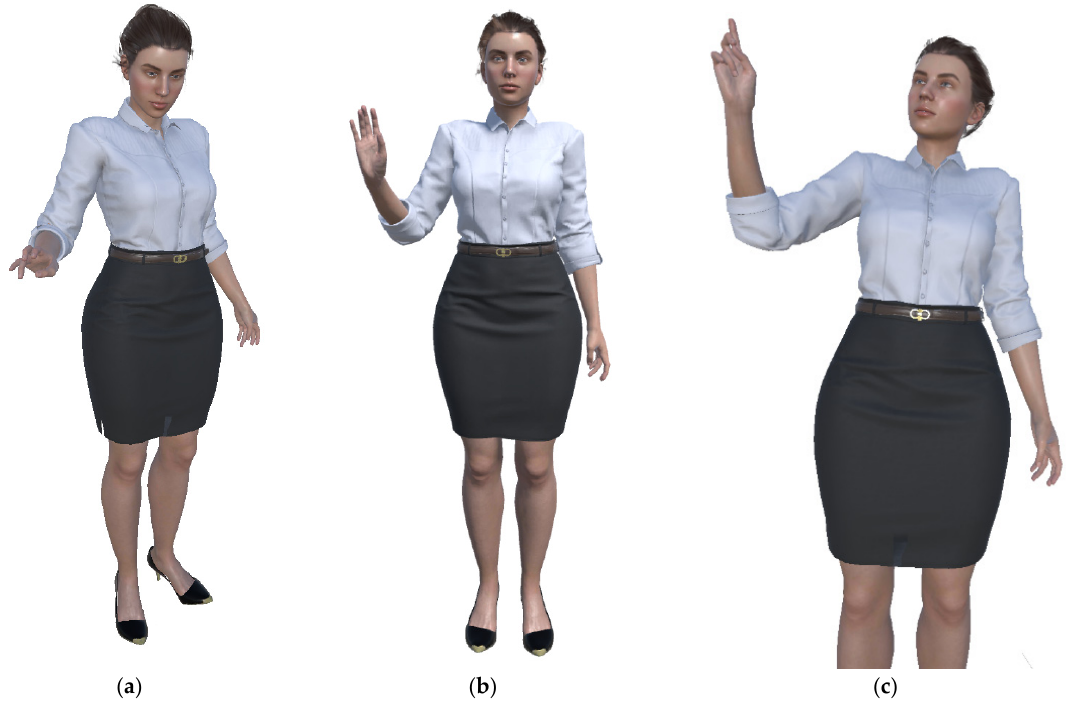
Figure 8. ( a ) Virtual assistance appearance. ( b ) Waving hello to the user, and ( c ) pointing to a section of the UI. of the UI.